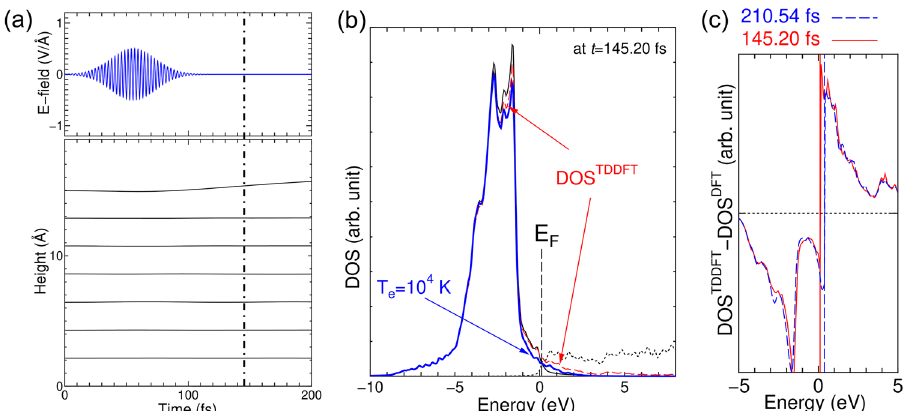
Figure 3. ( a ) TDDFT-MD simulation of Cu(111) 15 atomic-layer slab upon a laser shot with wavelength of 800 nm, FWHM of 30 fs, and fluence of 0.1 J/cm 2 . The upper panel shows the laser field, while the lower panel shows the height of each layer as a function of time. (Only the upper half of the slab is shown.) ( b ) Thick dash (red) curve is DOS TDDFT at t = 145.20 fs (corresponding to the dot-dashed vertical line in ( a )). The DOS DFT with atomic coordinates at the snapshot ( t = 145.20 fs) of the TDDFT-MD simulation is shown by solid (dotted) curve below (above) the E F . The thick solid (blue) curve shows the DOS DFT weighted by FDD with electronic temperature of 10 4 K. ( c ) Time evolution of the DOS TDDFT -DOSDOS DFT with the same atomic coordinates. Solid (red) line is at t = 145.20 fs, while the dash (blue) line is at t = 210.54 fs. Note that the vertical lines are location of the E F determined by the DFT calculation at each snapshot and that the dotted horizontal line is zero value of DOS TDDFT -DOS DFT